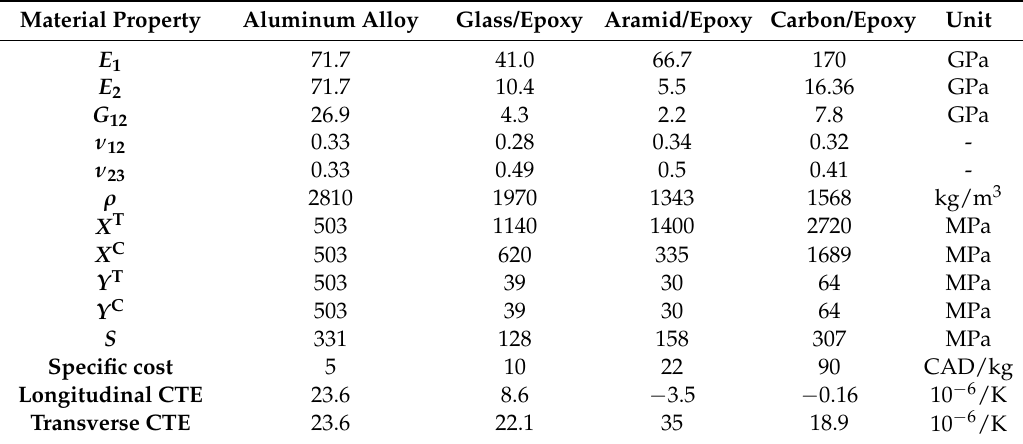
Table 7. Material properties used for the case studies.